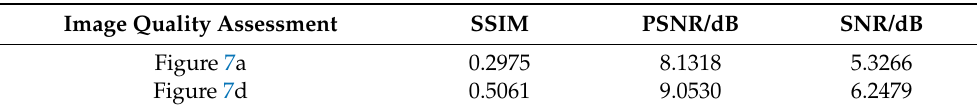
Table 3. The comparison of image quality